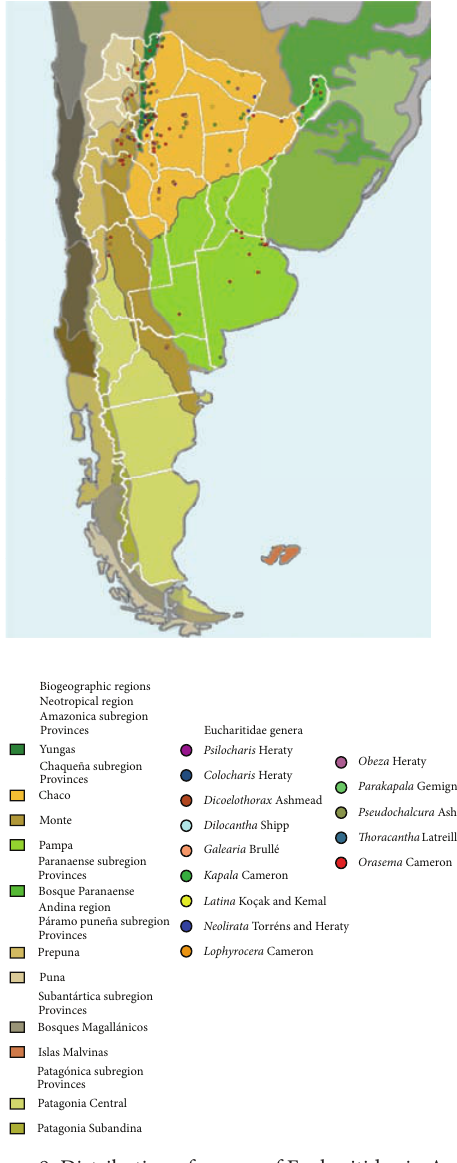
Figure 9: Distribution of genera of Eucharitidae in